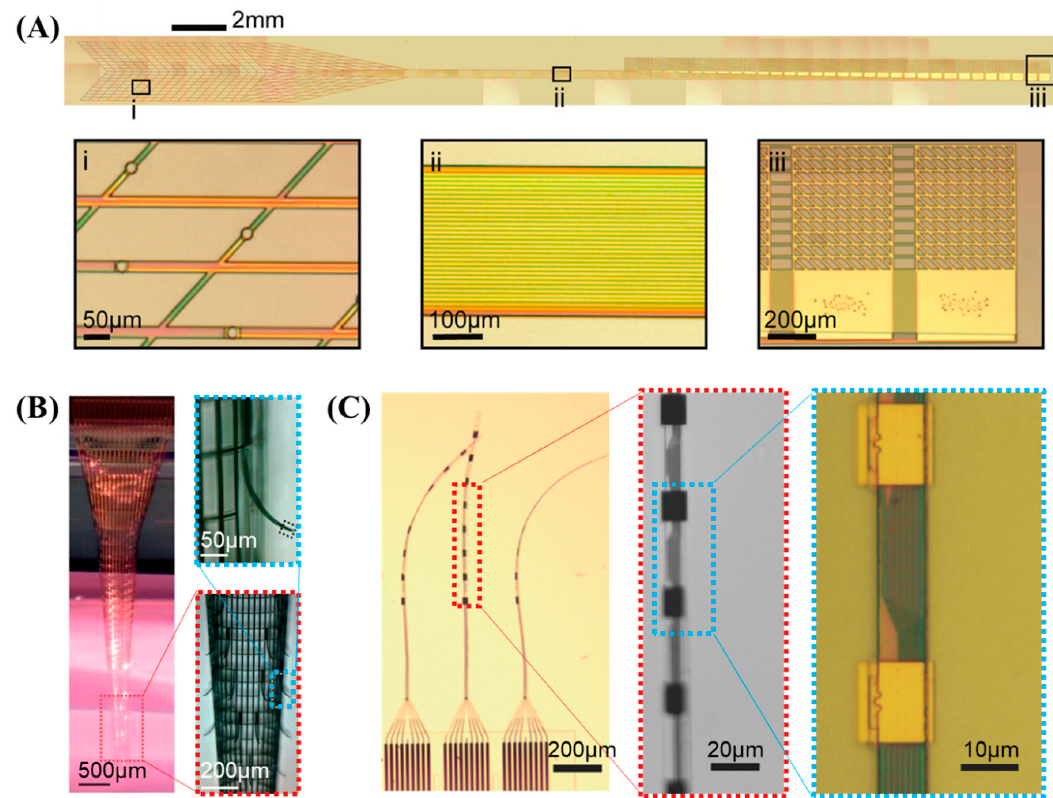
Figure 4. Mesh and thread probes: ( A ) syringe-injectable SU-8 mesh electronics with a plug-and-play input/output interface (reprinted from [173] with permission from American Chemical Society, Copyright 2017); ( B ) cylindrical, self-scrolled SU-8 mesh electronics (Reprinted from [170] by permission from Springer Nature Customer Service Centre GmbH, 2015); ( C ) nanoelectronic thread probe (reproduced from [176] with permission from John Wiley & Sons, copyright 2018).